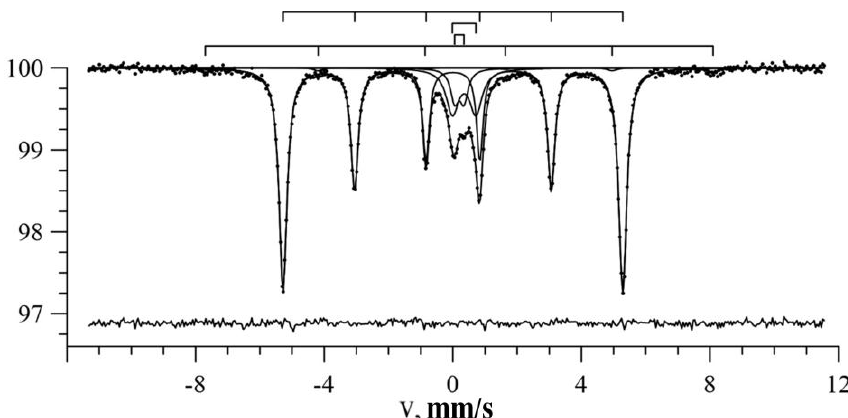
Figure 8. The result of the model interpretation of the Mössbauer spectrum of Fe nanotubes.